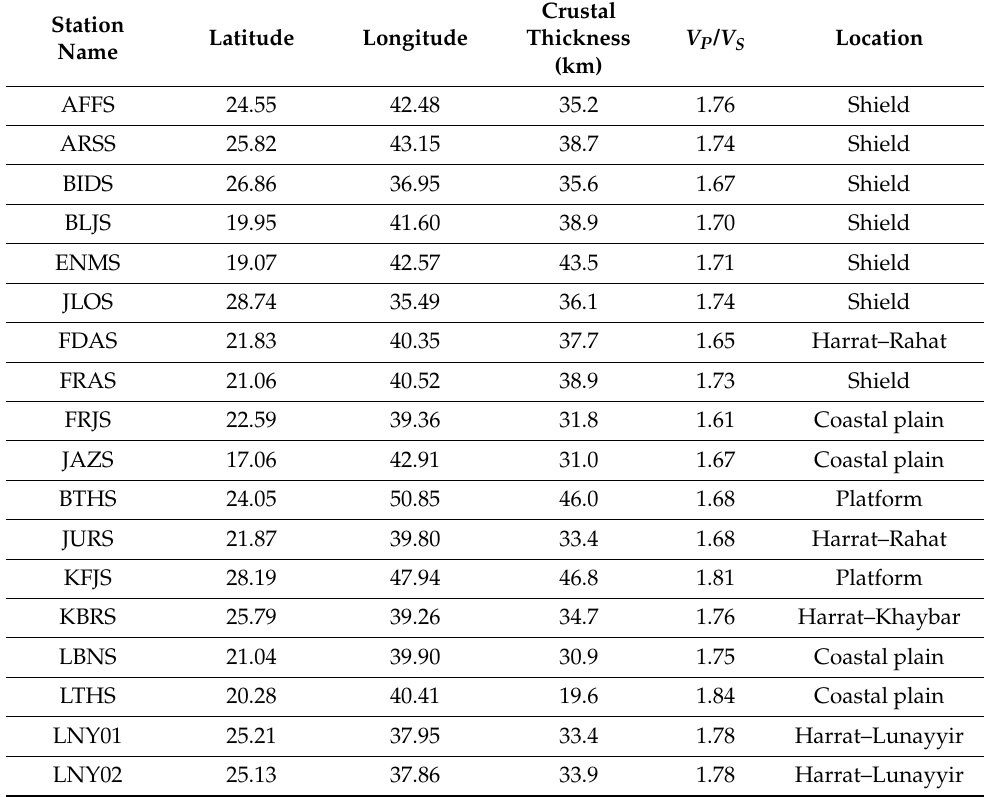
Table 1. Seismic stations: coordinates, Moho depth and Vp / Vs